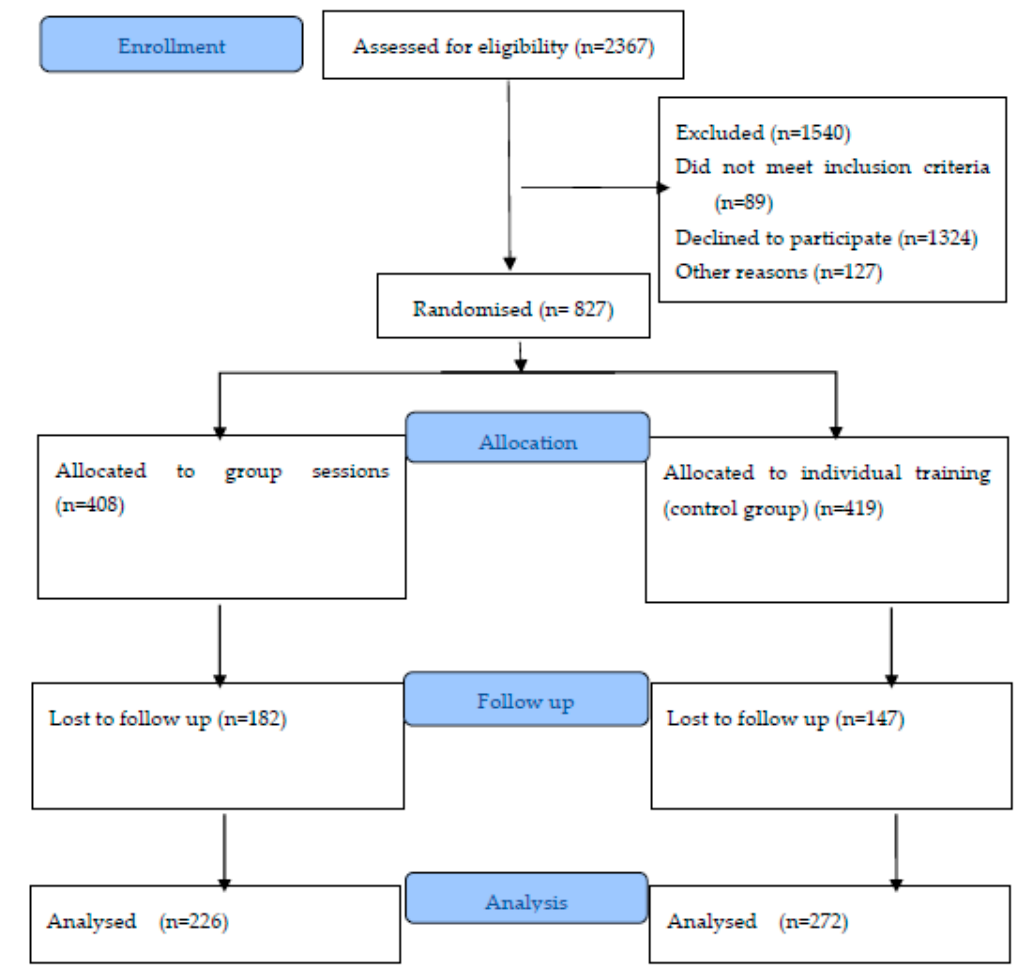
Figure 1. Consort Flow Diagram (2010).